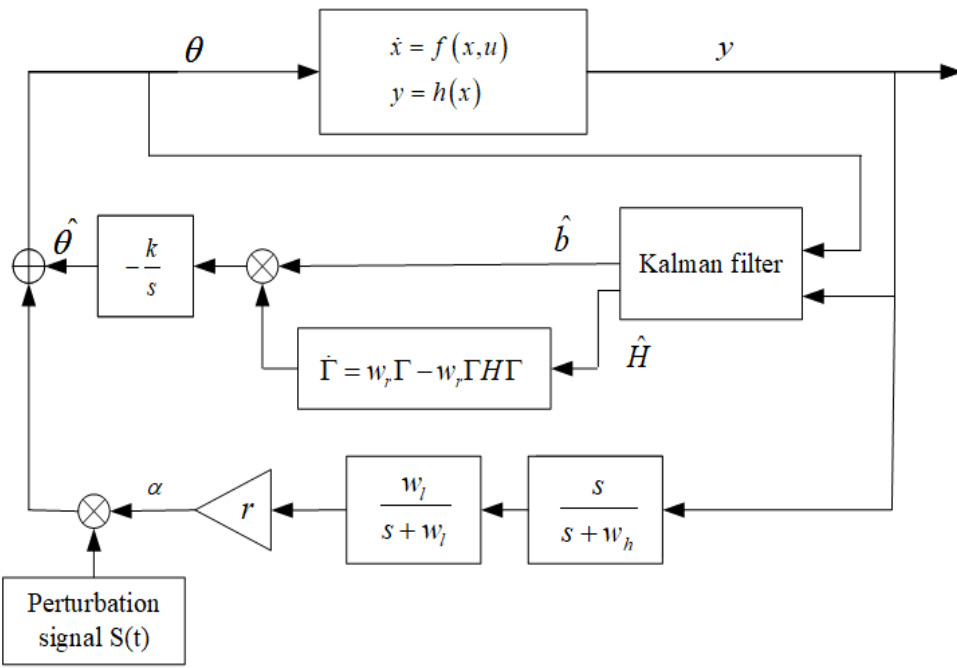
Figure 1. Structure of the Kalman filter based Newton extremum-seeking control for dynamic systems. The system input θ is obtained by superimposing the perturbation signal aS ( t ) to the (cid:95) θ of θ , which is produced by the Newton optimizer. In turn, the Kalman filter estimate computes the real-time gradient and Hessian estimates ˆ b and ˆ H for the output equilibrium map y = h ( l ( θ ))